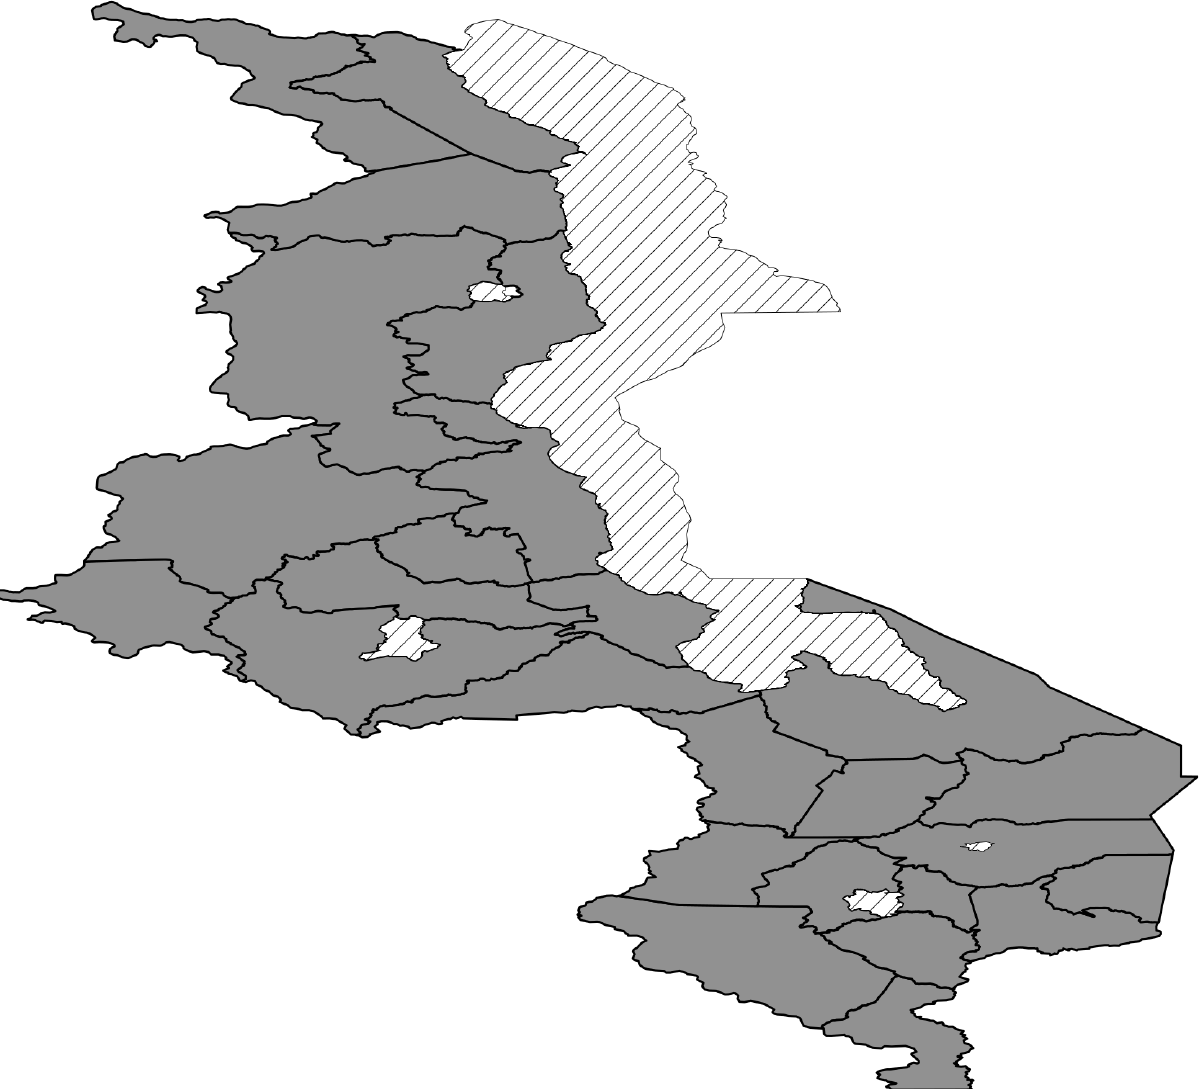
Fig 4. The 95% posterior credible intervals map for the spatial effects from the Gaussian model. Red means positive effect, green means negative effect and grey means insignificant effect.